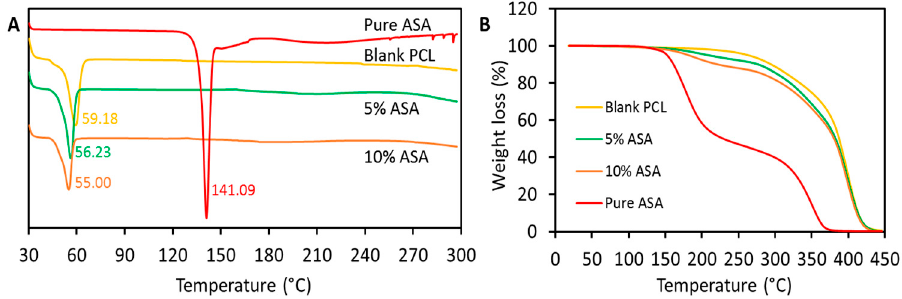
Figure 4. DSC ( A ) and TGA ( B ) analysis for the 3D-printed samples. For DSC curves: exo up.